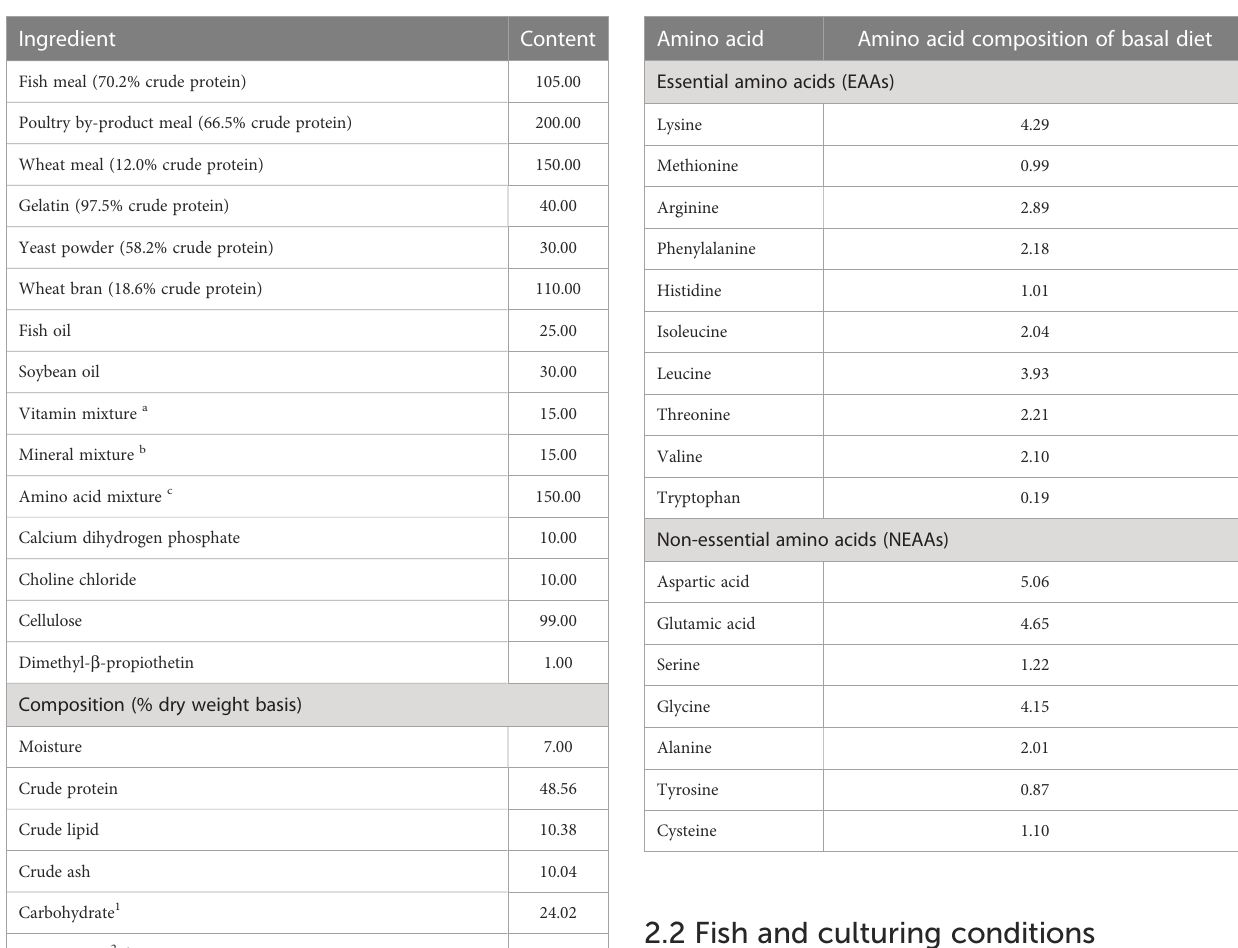
TABLE 1 Formulation and proximate analysis of the basal diet (g/kg diet). TABLE 2 The amino acid pro fi le of the basal diet (% dry